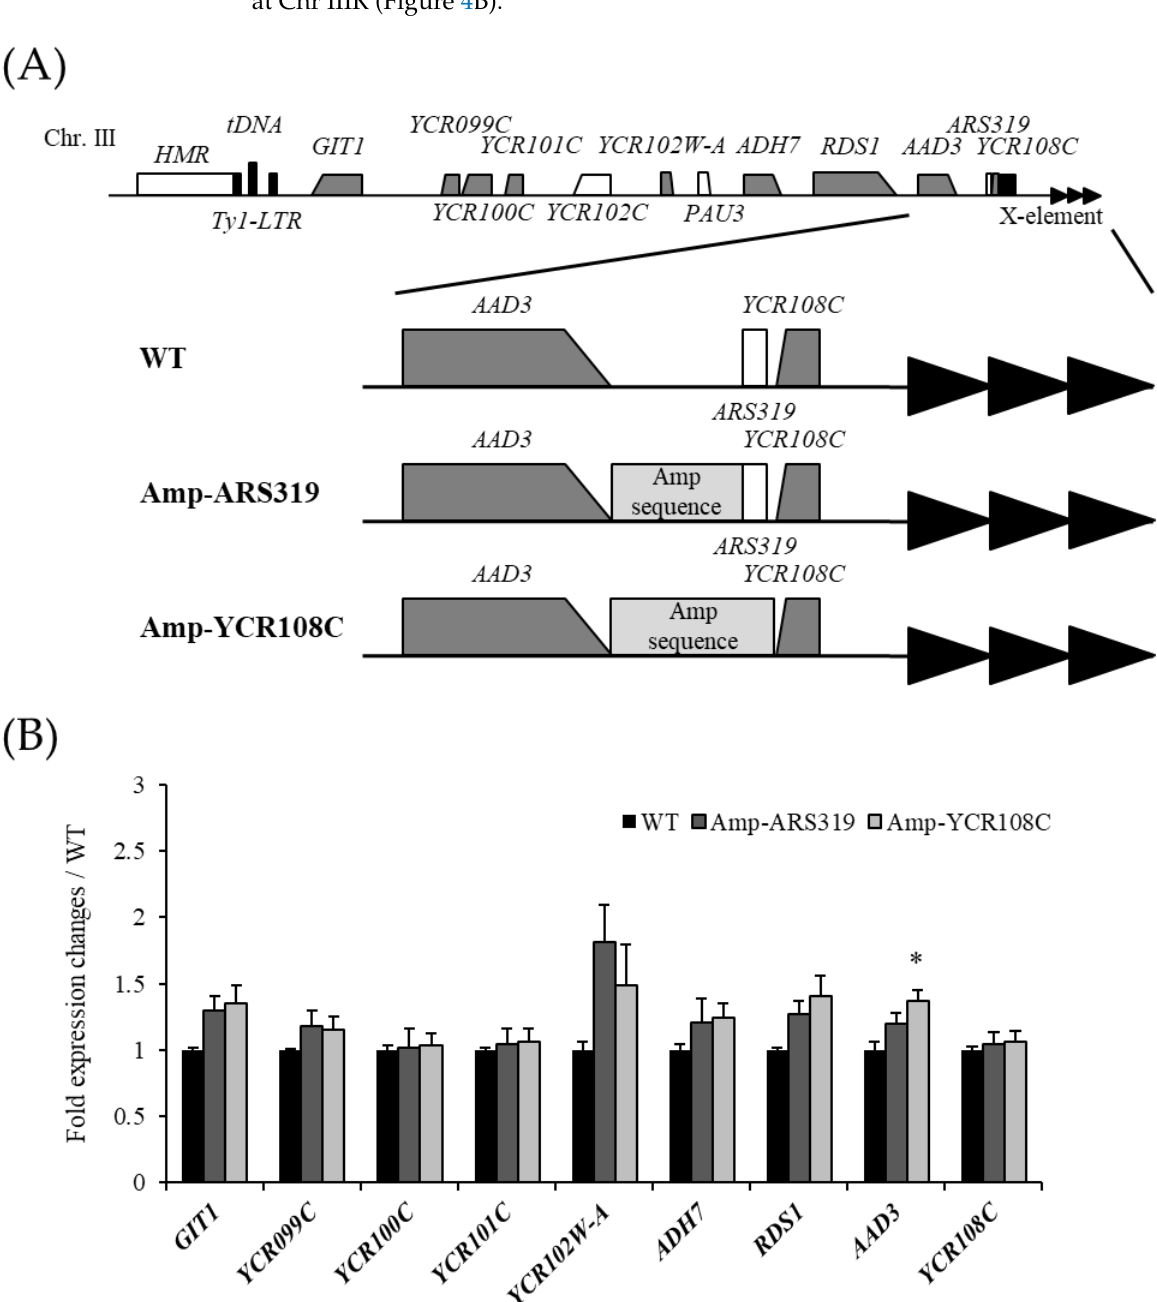
Figure 4. The boundary formation is DNA sequence-independent at the Chr III right telomere. ( A ) Gene map of Chr IIIR in Amp-ARS319 and Amp-YCR108C strains. ( B ) Expression level of Chr IIIR genes in Amp-ARS319 and Amp-YCR108C strains by RT-qPCR. Asterisks mean p < 0.05 compared with WT (Student’s T-test). Error bars show standard errors calculated from three independent experiments.